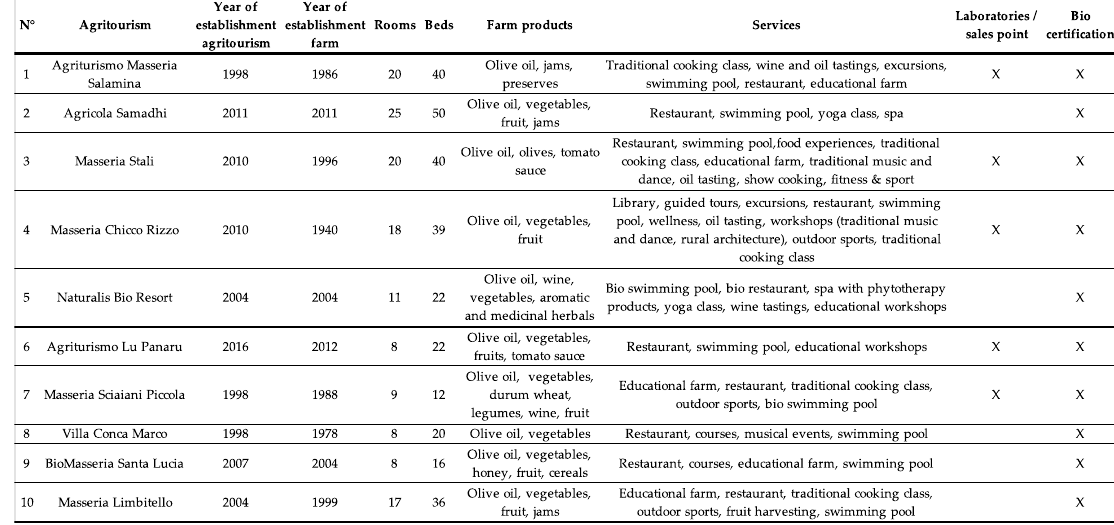
Figure A1. The 10 case studies.